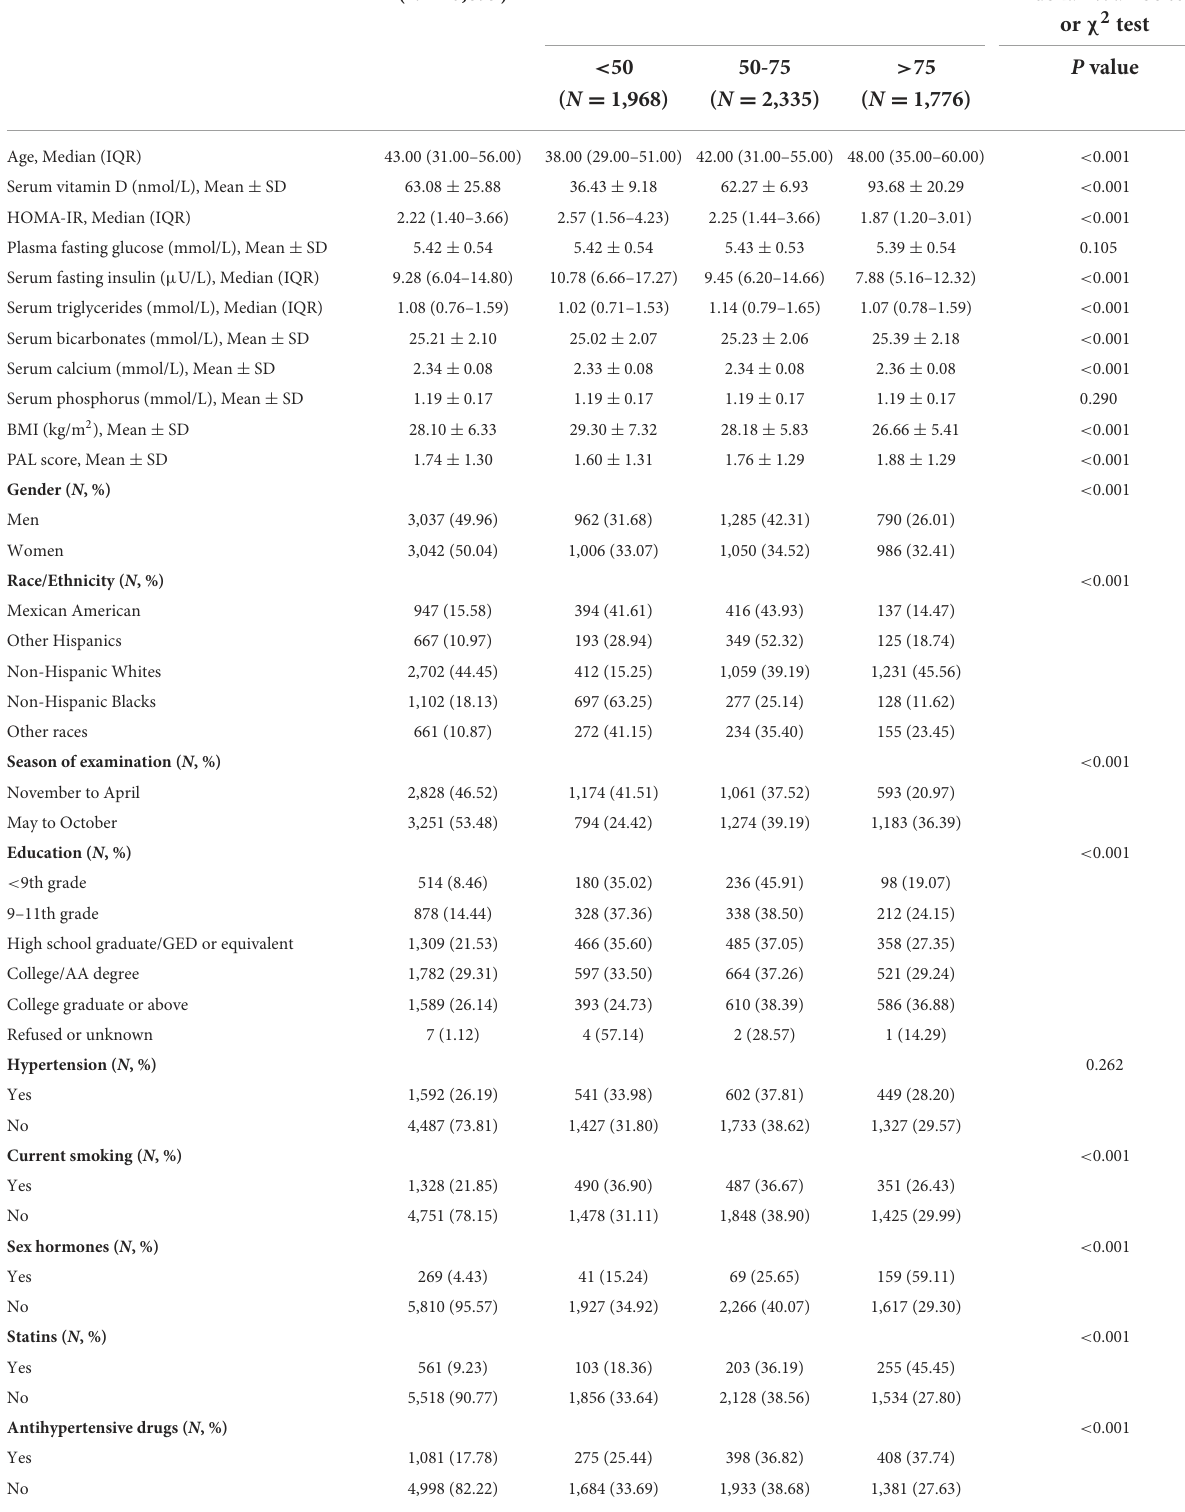
TABLE 1 Baseline characteristics of participants and distribution across different vitamin D